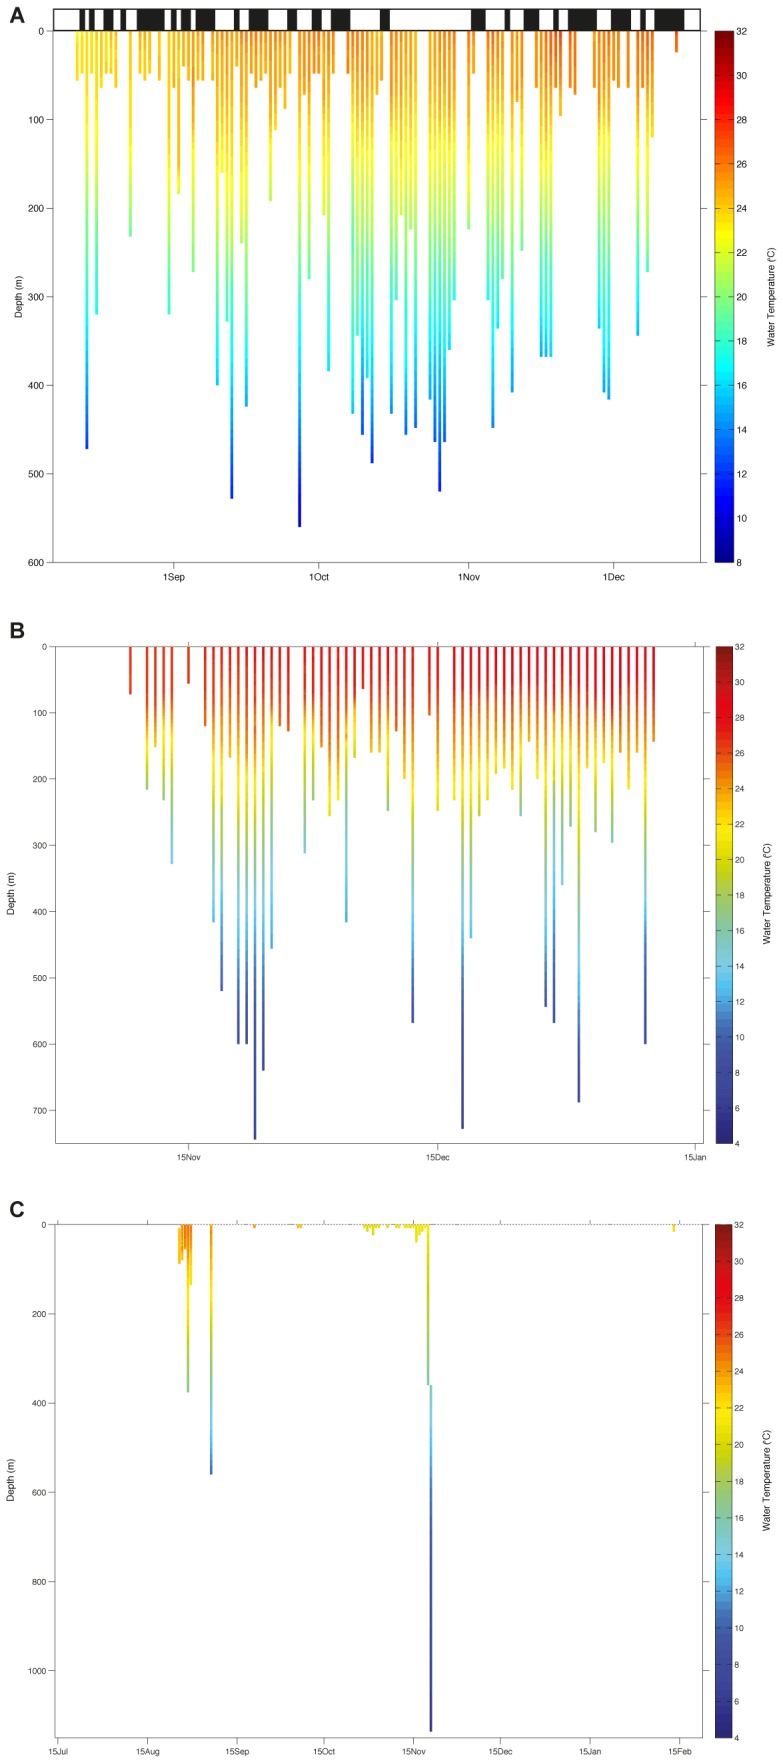
Depth-temperature profiles of selected PSAT tagged tiger sharks.(A) TS25 Chesterfield Islands, (B) TS11 South lagoon of New Caledonia, and (C) TS9 South Lagoon of New Caledonia. Black bars above A refer to periods of acoustic detection in the Chesterfield array. Note differing spatial and temporal scales.